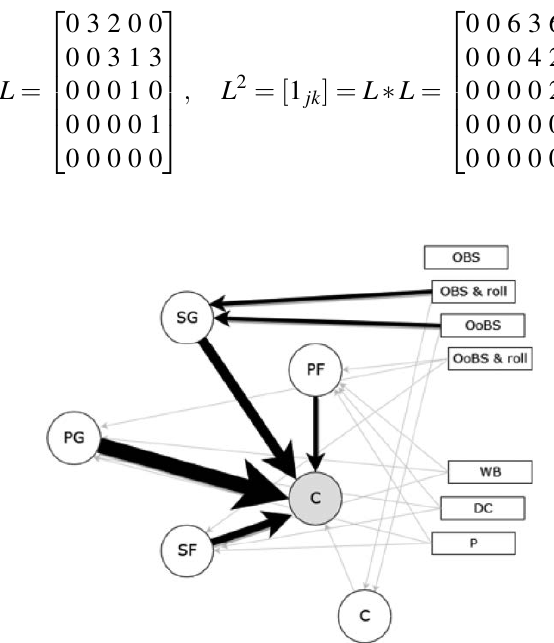
Fig. 1 Generalized path diagram of passing on